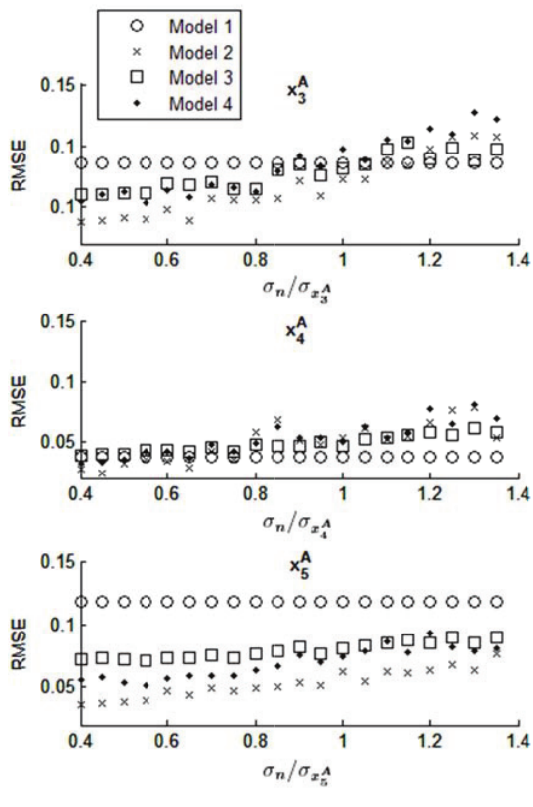
Fig. 7. Compa ensembles and